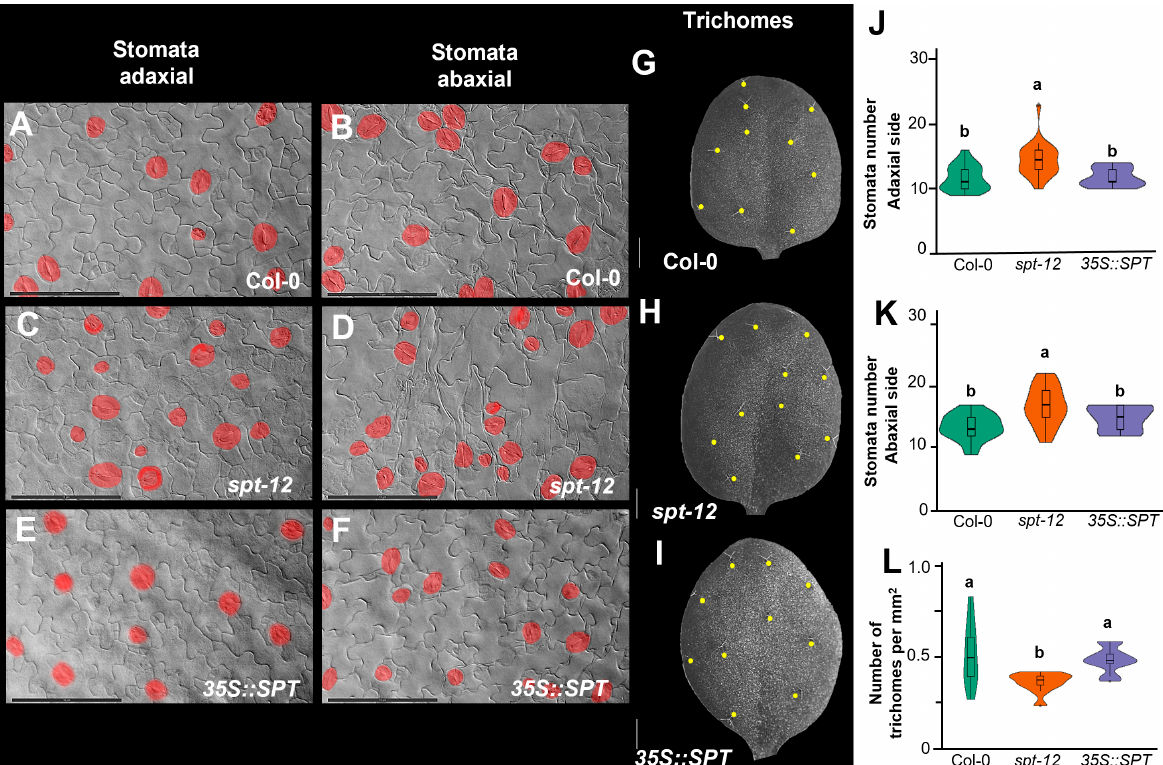
Figure 3. SPT is implicated in the development of stomata in cotyledons and trichomes on leaves. ( A ) Adaxial part of a cotyledon of wildtype (WT). ( B ) Abaxial part of a cotyledon of WT. ( C ) Adaxial part of a cotyledon of spt-12. ( D ) Abaxial part of a cotyledon of spt-12 . ( E ) Adaxial part of a cotyledon of 35S::SPT . ( F ) Abaxial part of a cotyledon of 35S::SPT . ( G – I ) Adaxial part of leaves of WT, spt-12 , and 35S::SPT , respectively. ( J , K ) Quantification of stomatal number of the adaxial and abaxial part